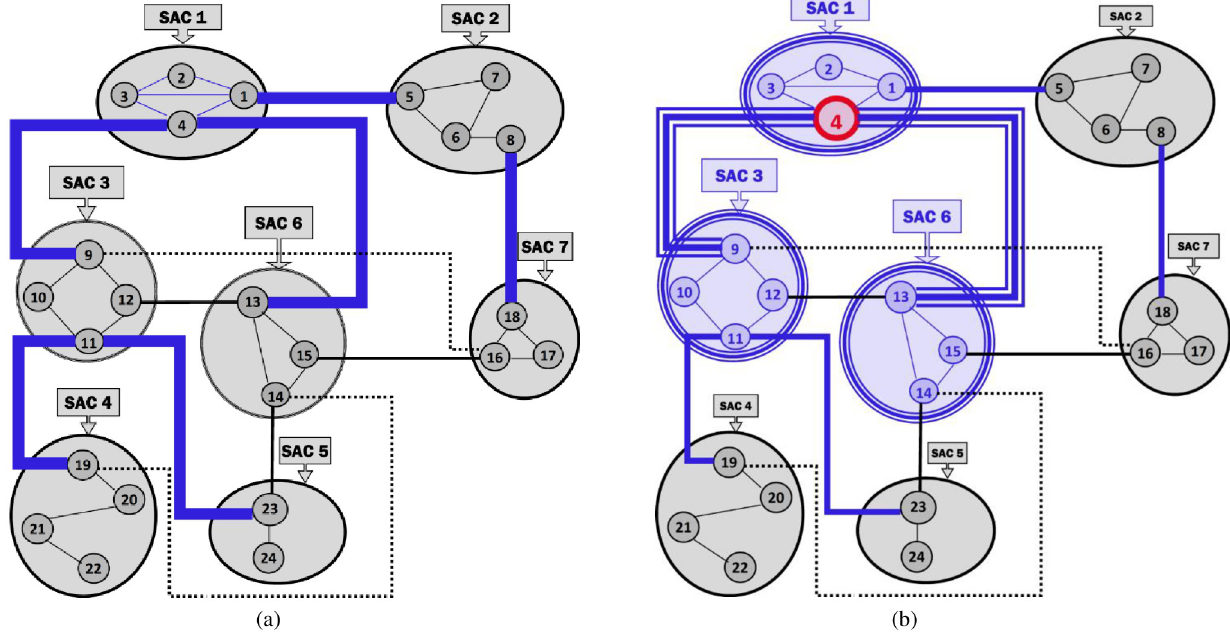
Fig 21. (a) The path of the MaxST in our running MRG example shown in Fig 20, and (b) the densest multi-profiled cross-SACs, to which the active user described in Example 9 belongs (i.e., the cross-SACs of SACs 3 and